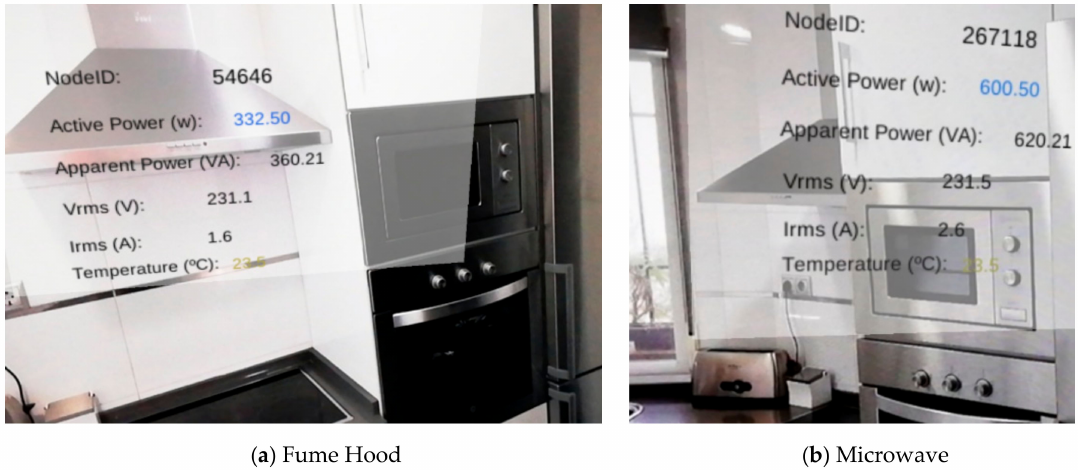
Figure 9. Augmented energy information displayed on the screen of the smartphone.